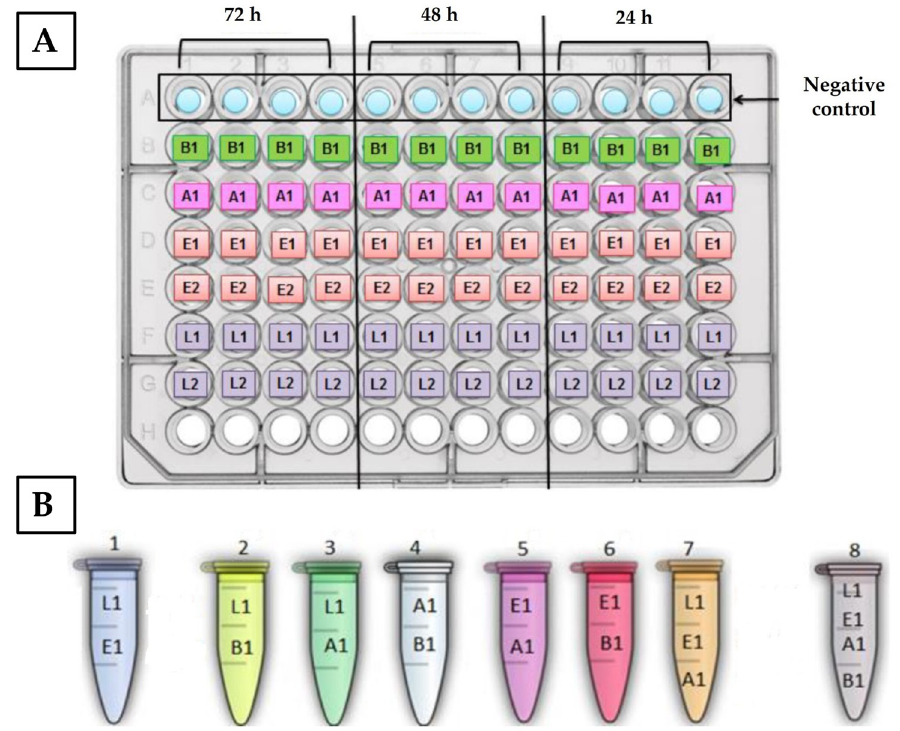
Figure 1. Schematic representation of the polystyrene 96-well microtiter plates inoculated with pure bacterial suspensions, for the incubation periods of 72, 48, and 24 h at 25 °C, or 5, 12, and 16 days at 4 °C ( A ), and mixed cultures used for subsequent assays ( B ). B1— B. thermosphacta ATCC11509 T ;